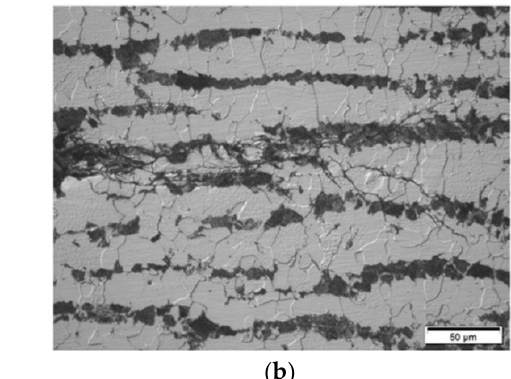
Figure 23. Section No2: 90–140. Coordinate 135 mm, 6.8 mm from ID, blistering cracking in pearlite band, magnification 200× ( a ), 500× ( b ).